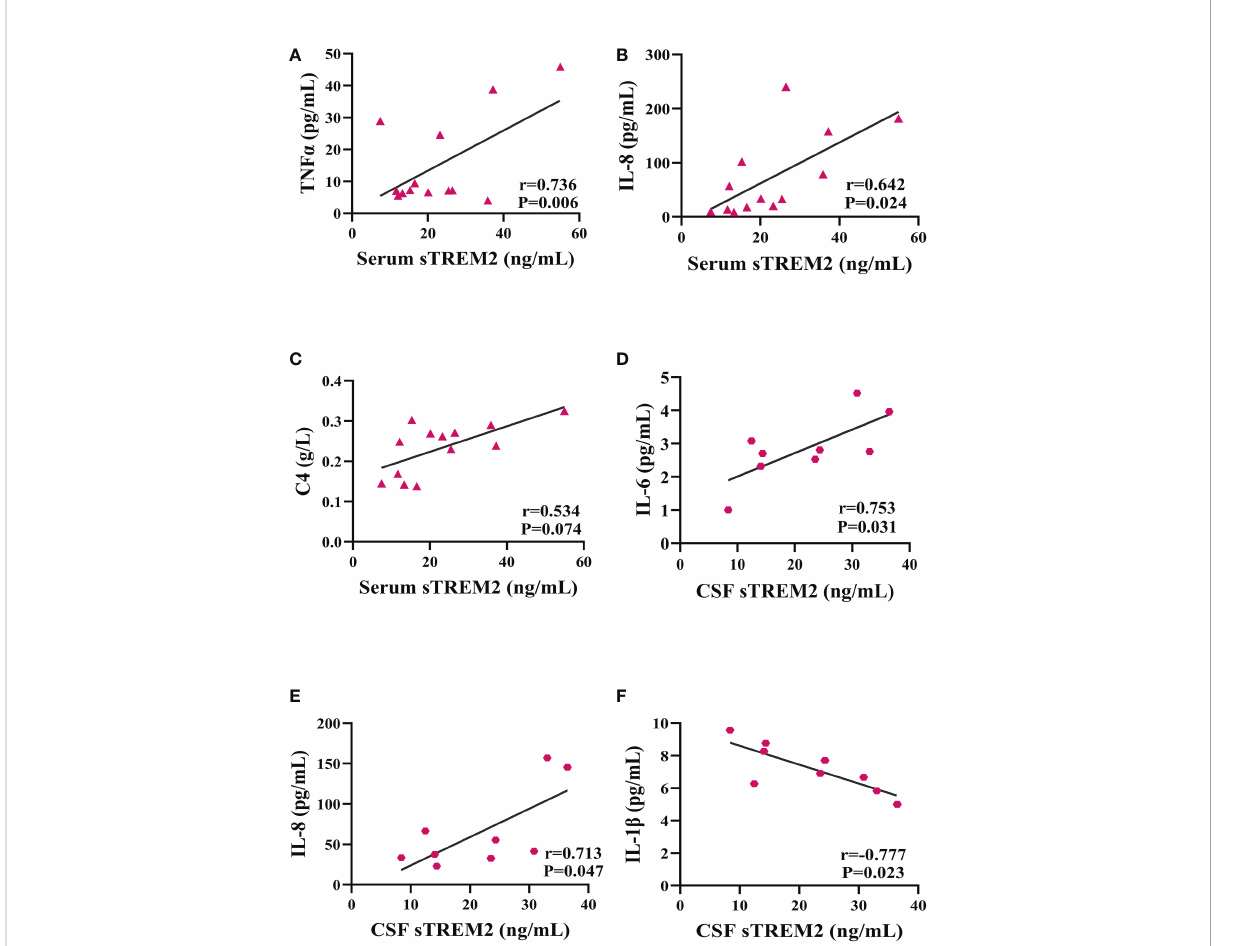
FIGURE 3 sTREM2 levels correlated with neuroin fl ammatory factor levels. Partial correlation analyses after controlling for age. (A – C) In the serum samples of PACNS patients (n=13), the sTREM2 concentration was positively correlated with the TNF a , IL-8 and C4 concentrations. (D – F) In the CSF samples of PACNS patients (n=9), the sTREM2 concentration was positively correlated with the IL-6 and IL-8 concentrations and negatively correlated with the IL-1 b